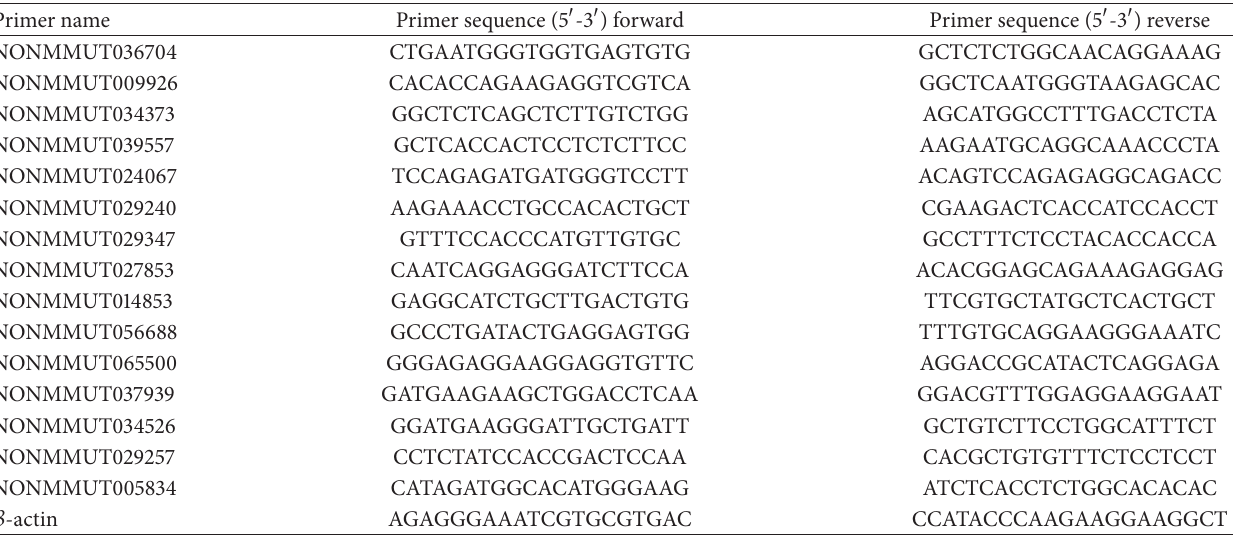
Table 1: Primers used for RT-qPCR